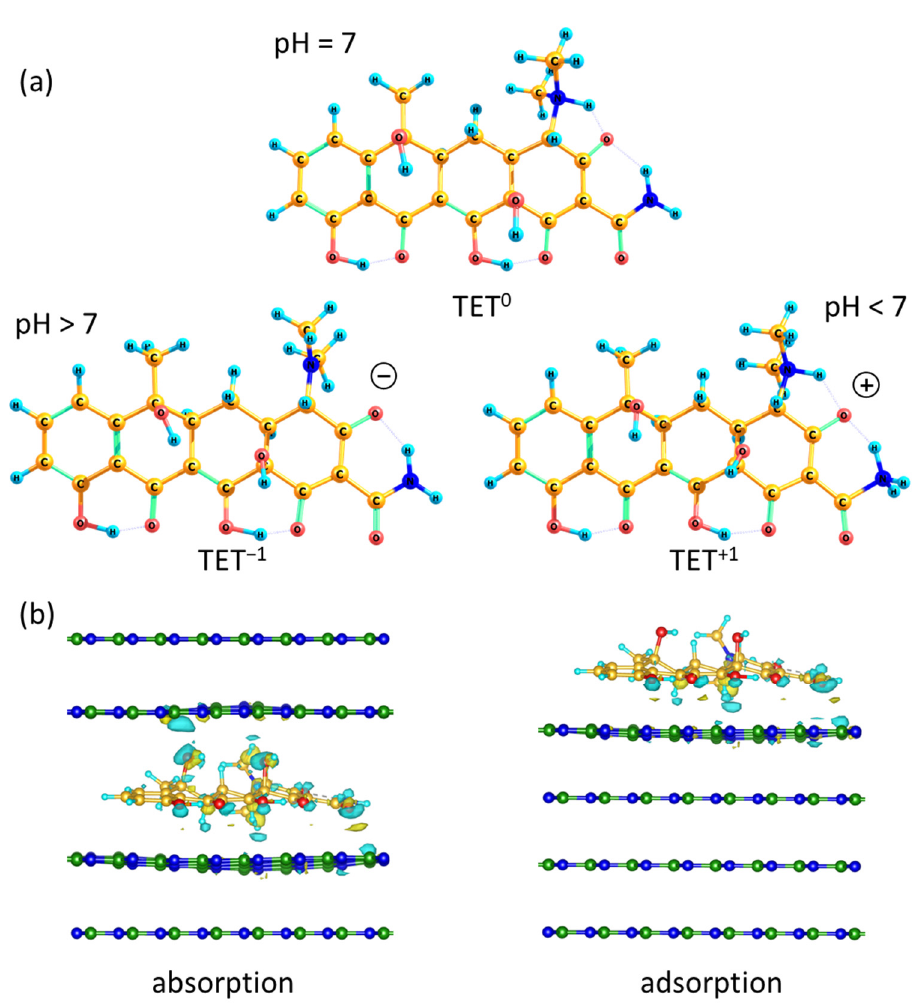
Figure 5. Schematics of tetracycline structure with different charges ( a ) and absorption and adsorption models of TET–BN systems ( b ). TET is considered in three states corresponding to three pH solutions: neutral (TET 0 ), negatively (TET − 1 ), and positively (TET +1 ) charged.